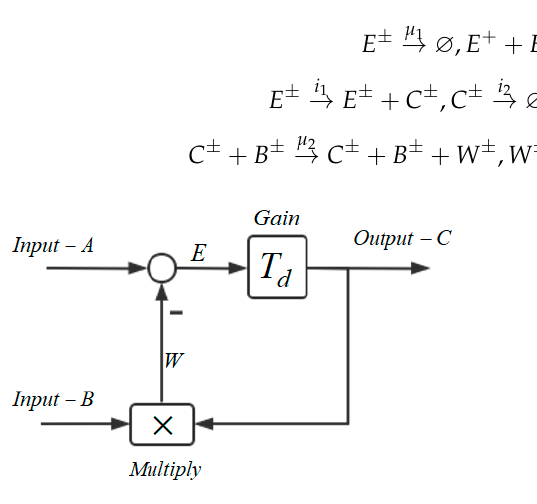
Figure 13. Leak reactions lead to errors in calculation results: ( a ) leak in the initial specie A ; ( b ) leak in the initial specie B . Figure 12. The structure of the division gate.